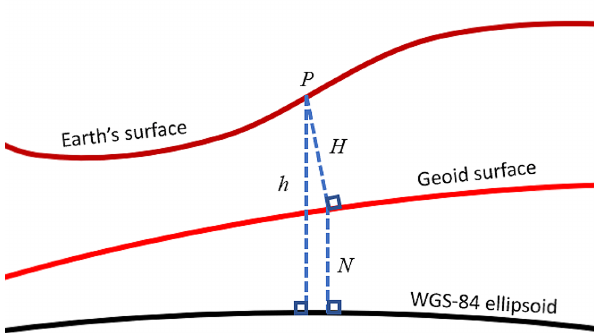
Figure 7. Gravity description with respect to geoid and reference ellipsoid